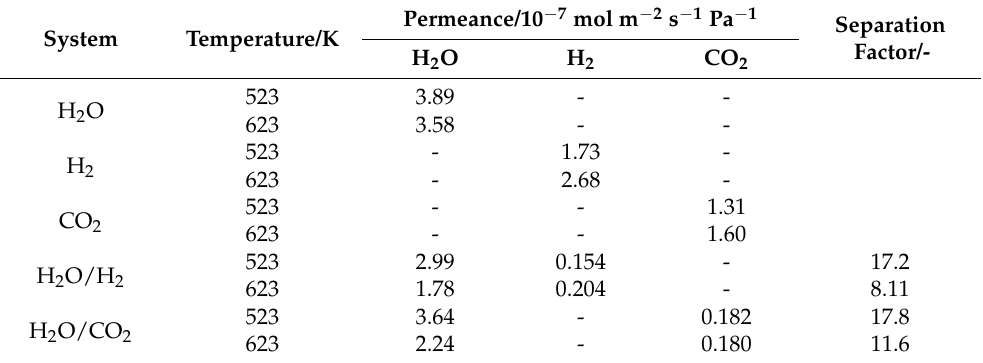
Table 1. Results of separation tests for binary mixtures and single gas permeation